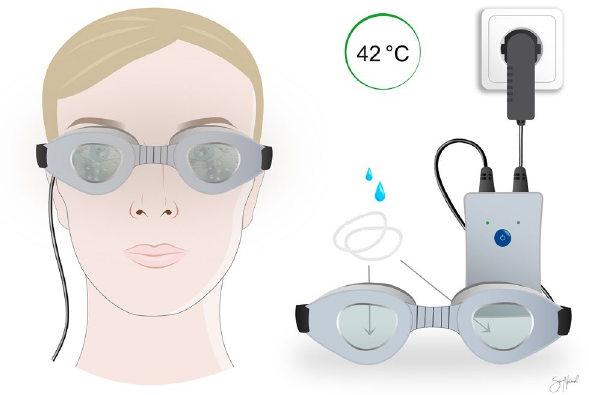
Figure 1. Blephasteam (Spectrum Thea Pharmaceuticals LTD, Macclesfield, UK) warms the eyelids by turning water in cotton rings into steam while placed over the eyes for 10 min. Figure created in Affinity Designer version 1.8 (Serif (Europe) Ltd., Nottingham,